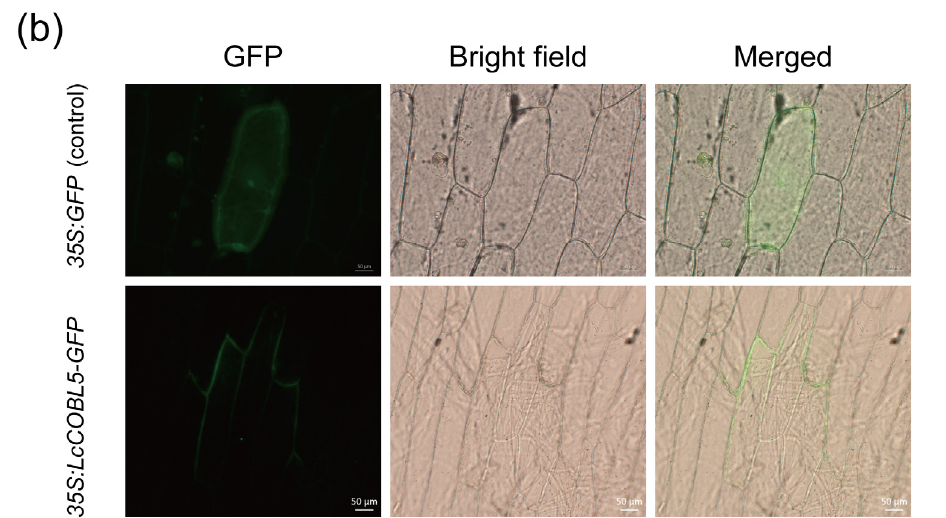
Figure 7. Subcellular localization of LcCOBL5 protein in L. chinense calli ( a ) and onion epidermal cells ( b ). In these pictures, GFP indicates green fluorescence photography, bright field indicates bright-field photography, RFP indicates red fluorescence photography and merged indicates the fusion of green fluorescence, red fluorescence and bright field photography. The red fluorescence locates the nucleus, and the green fluorescence locates the LcCOBL proteins.